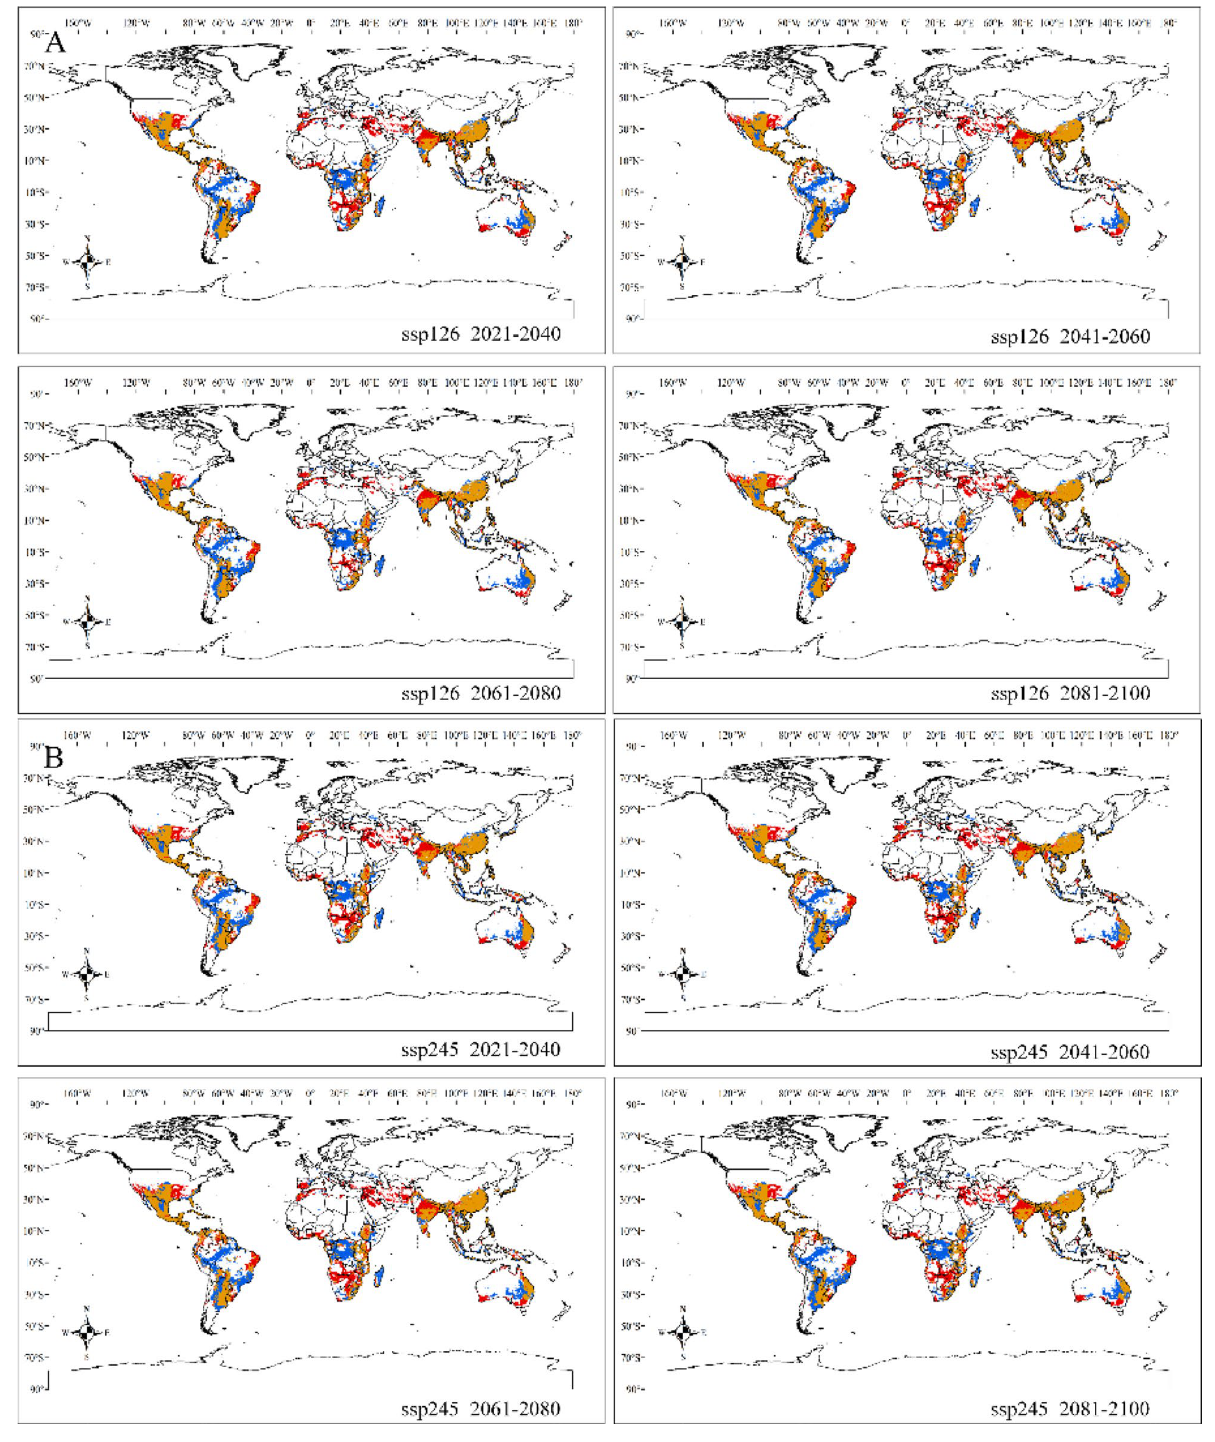
Figure 3. Changes in the distribution of potential suitable habitats for Sapindus under the ssp126 ( A ), ssp245 ( B ), ssp370 ( C ), and ssp585 ( D ) scenarios from years 2020 to 2100 compared with the current distribution of suitable habitats. Note: Red areas indicate habitat expansion, yellow areas indicate no change and blue areas indicate habitat contraction. Created in ESRI ArcMap 10.5 (https:// suppo rt. esri. com/ en/ Produ cts/ Deskt op/ arcgis- deskt op/